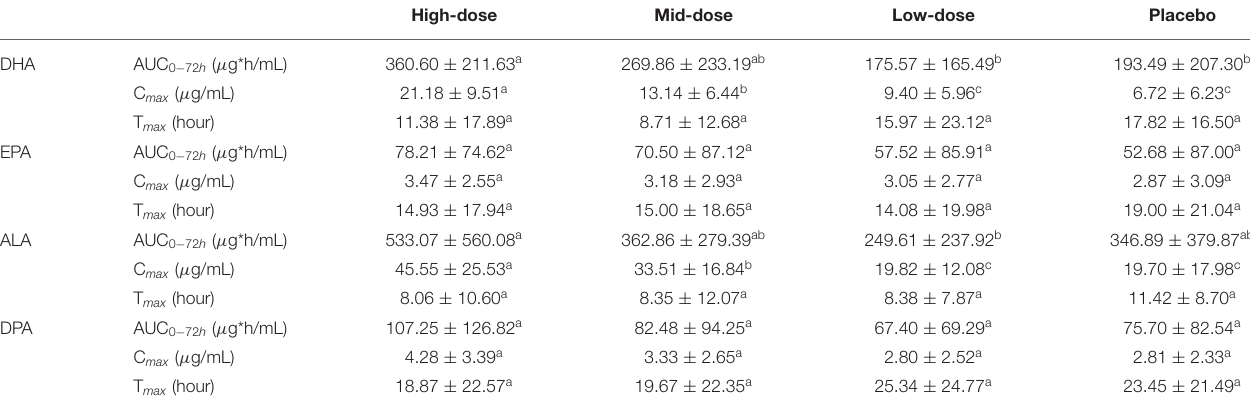
TABLE 3 | Baseline-corrected plasma PK parameters for DHA, EPA, ALA, and DPA within 72 h post-dose of LC- ω 3-rich canola oil. High-dose Mid-dose Low-dose Placebo